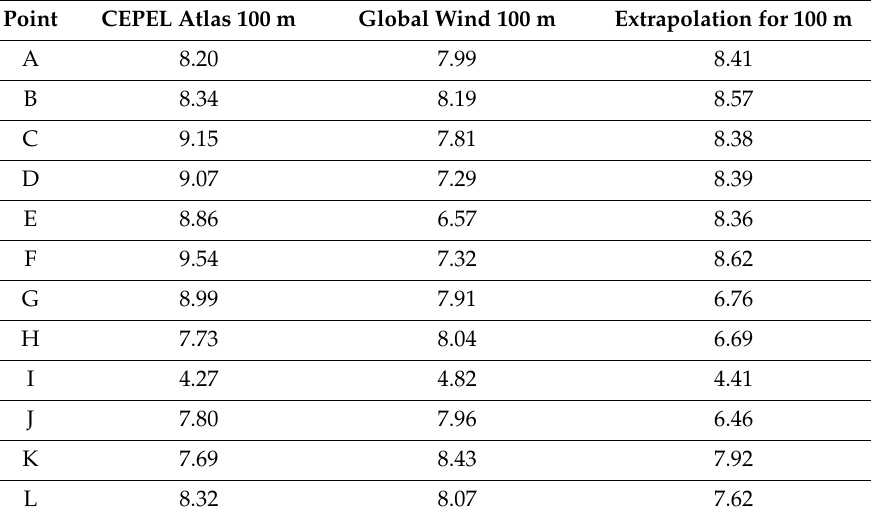
Table 1. Friedman’s non-parametric statistical